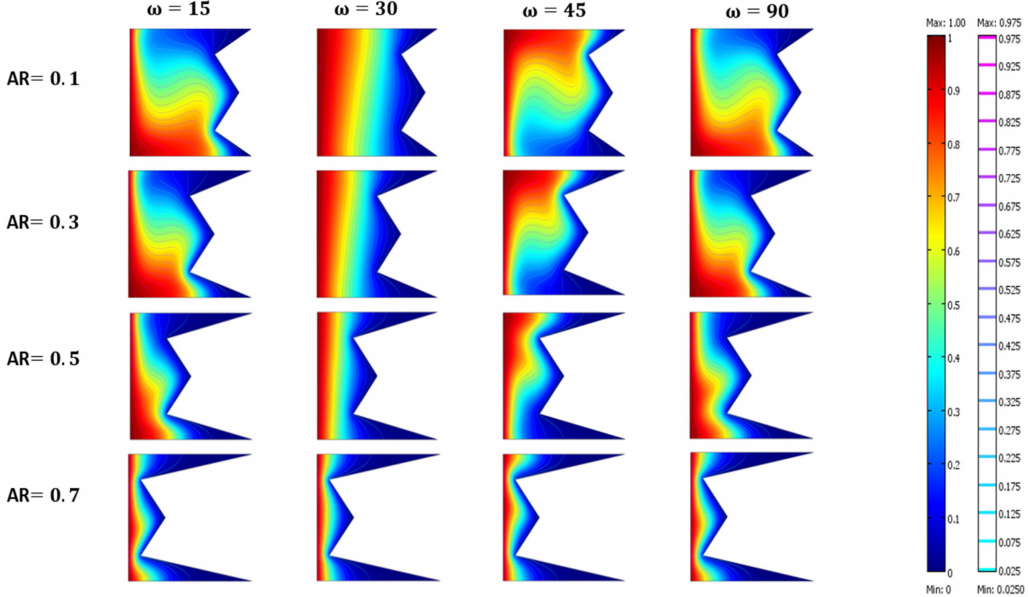
Figure 17. Isotherms for di ff erent angles of inclination ω and aspect ratios with Ra = 10 5 , Ha = 15, Da = 10 − 2 , ϕ = 0.04, Fr = 0.75 and q ∗ = 1.